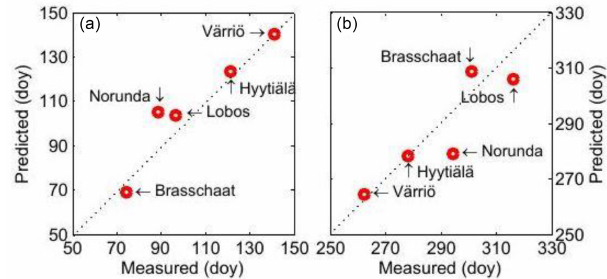
Figure 3. (a) The relationship between measured and predicted on- set dates of photosynthesis in the five studied ecosystems; (b) the cessation dates of photosynthesis in the five